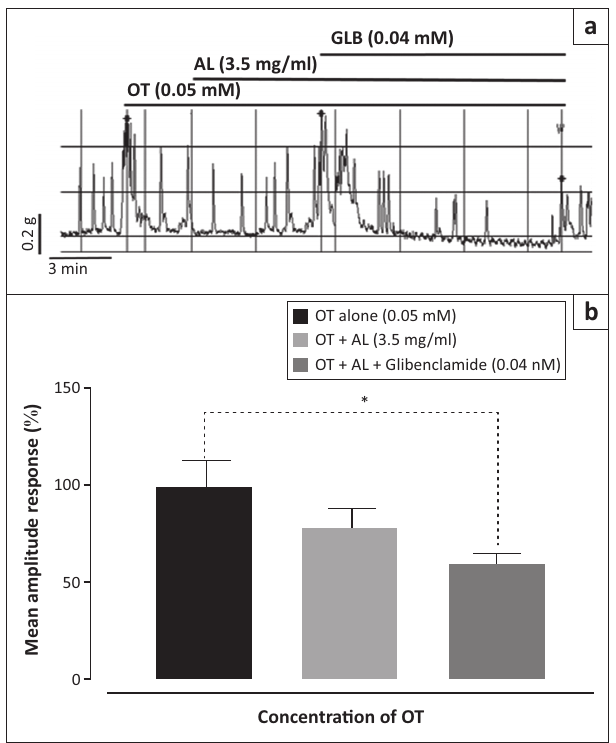
FIGURE 7: Effect of Alchornea laxiflora (AL) on oxytocin (OT)-induced uterine contraction in the presence of glibenclamide, an ATP-dependent K + -channel blocker. Figure a represents original recording of the effect of AL on OT-induced (0.05 mM) uterine contraction in the absence and presence of glibenclamide (0.04 mM). Figure b represents bar plot analysis of the response of OT to AL in the absence and presence of glibenclamide. Significant inhibition ( p < 0.05) of OT by AL in the presence of amiodarone was observed. n = 4 animals; ** p < 0.05; GLB =